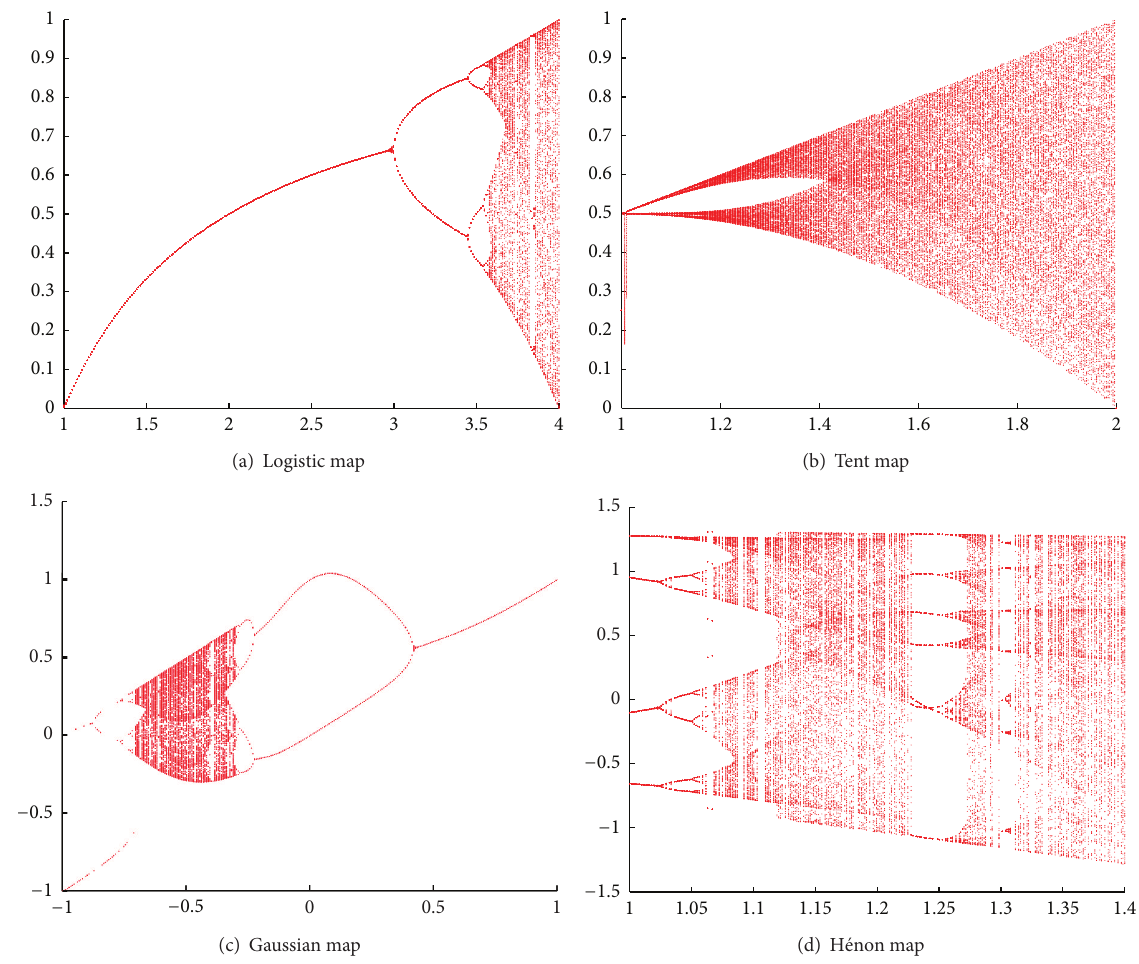
Figure 2: Bifurcation digrams of (a) logistic map, (b) tent map, (c) Gaussian map, and (d) H´enon map. Parameter 𝜇 in logistic map can be set at (0, 4] ; chaos happens when 𝜇 = 4 in (a). Parameter 𝜇 in tent map can be set at [1,2] ; chaos happens when 𝜇 = 2 in (b). Parameter 𝛽 in tent map can be set at [−1, +1] ; chaos happens when 𝛼 = 6.20 and 𝛽 = −0.5 in (c). Parameters 𝑎 = 1.4 and 𝑏 = 0.3 are a classic setting in H´enon map; one of its invariant points on the attractor, 𝑥 = (√609 − 7)/28 = 0.631354477 and 𝑦 = (3√609 − 7)/280 = 0.189406343 , can be used as an initial value